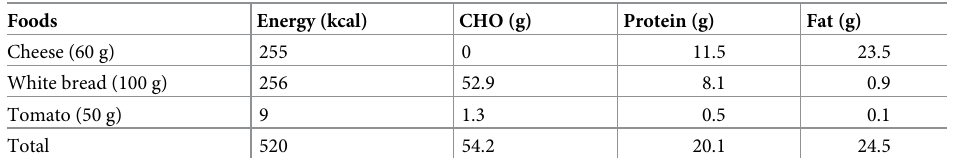
Table 2. Energy and macro nutrient composition of per sandwich served at lunch.